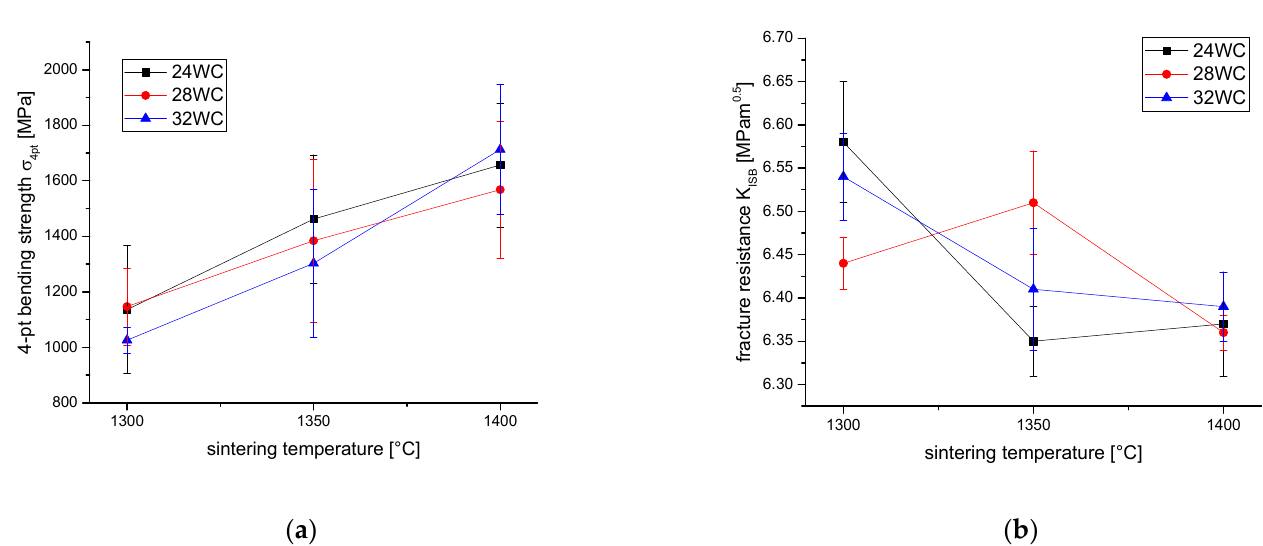
Figure 2. ( a ) 4-point bending strength σ 4pt of TZP-WC composites depending on tungsten carbide volume fraction and sintering temperature. ( b ) Fracture resistance K ISB of TZP-WC composites depending on tungsten carbide volume fraction and sintering temperature.